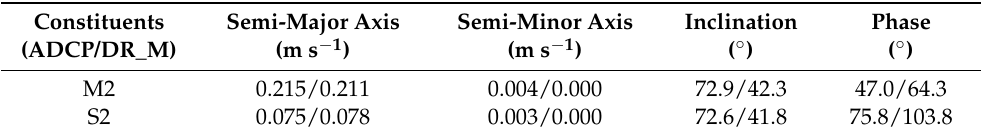
Table 3. Tidal ellipse parameters of dominant semidiurnal tidal components for the ADCP observa- tion and DR_M output.